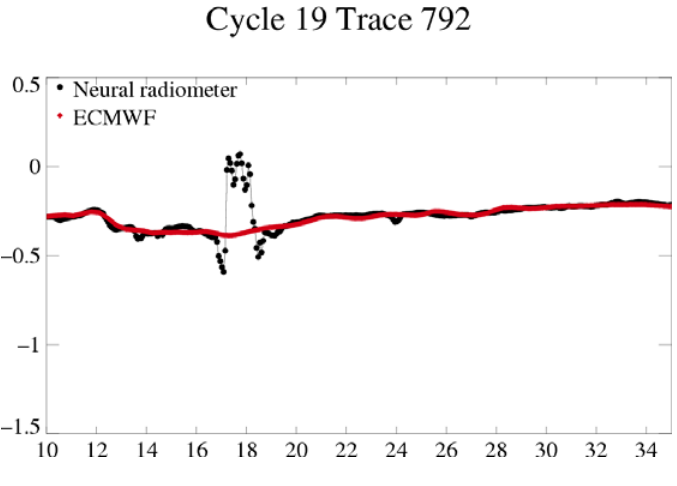
Figure 5. values of the neural radiometer and ECMWF wet troposphere corrections (in m) for Envisat during TC Isabel, in function of latitude